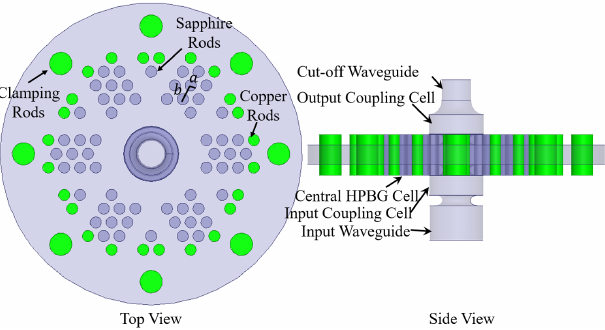
FIG. 4. The model of the HPBG structure as a central cell sandwiched between conventional input and output cylindrical coupling cells in the 3D simulation.